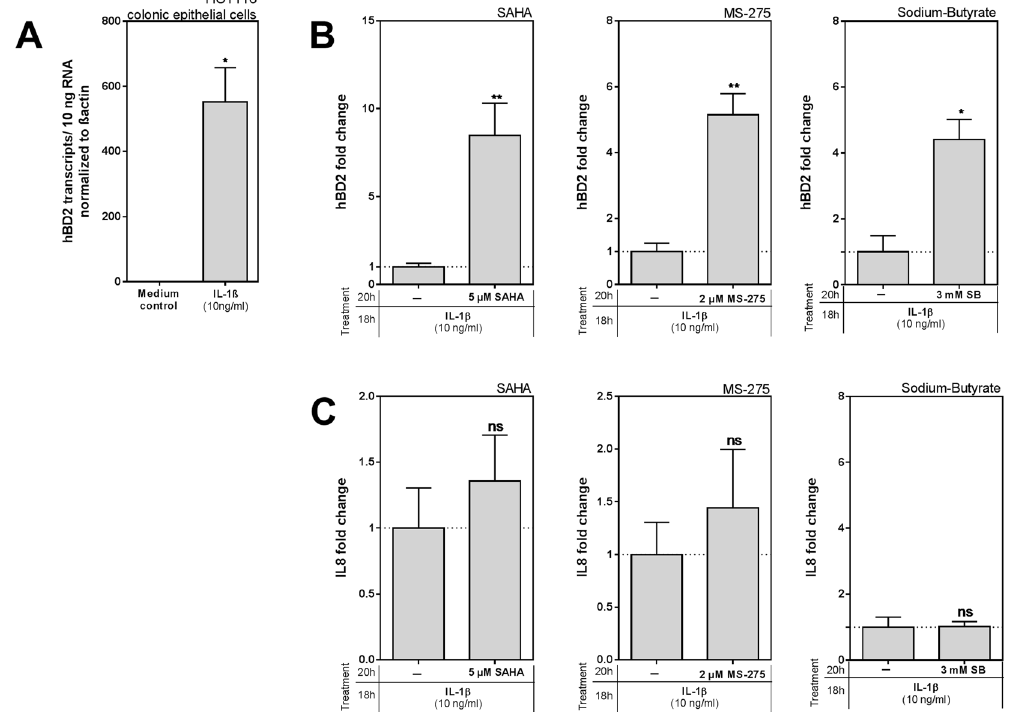
Figure 3. Interleukin 1 β (IL1 β )-mediated human β -defensin 2 (hBD2) induction is enhanced by histone deacetylase (HDAC) inhibition in HCT116 cells. ( A ) Induction level of hBD2 mRNA in HCT116 cells by IL1 β (10 ng/ml) after 18 hrs of stimulation. Fold change in hBD2 ( B ) or IL8 ( C ) induction are shown compared to IL1 β stimulation alone when co-treated with either SAHA (5 µ M), MS-275 (2 µ M), or SB (3 mM). Inhibitor treatment and stimulation were done exactly as for CaCo-2/TC7 cells. Depicted are results of at least three independent experiments carried out in biological triplicates. * p < 0.05, ** p < 0.01, evaluated by Mann- Whitney u